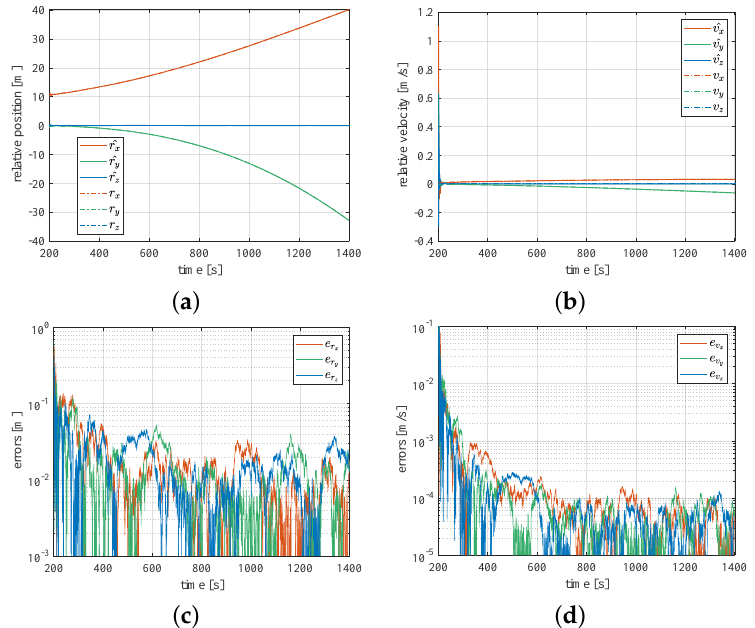
Figure 7. The estimations of the position state of the object after the collision: ( a ) estimation of the relative position; ( b ) estimation of the relative velocity; ( c ) error of the relative position estimation; ( d ) error of the relative velocity